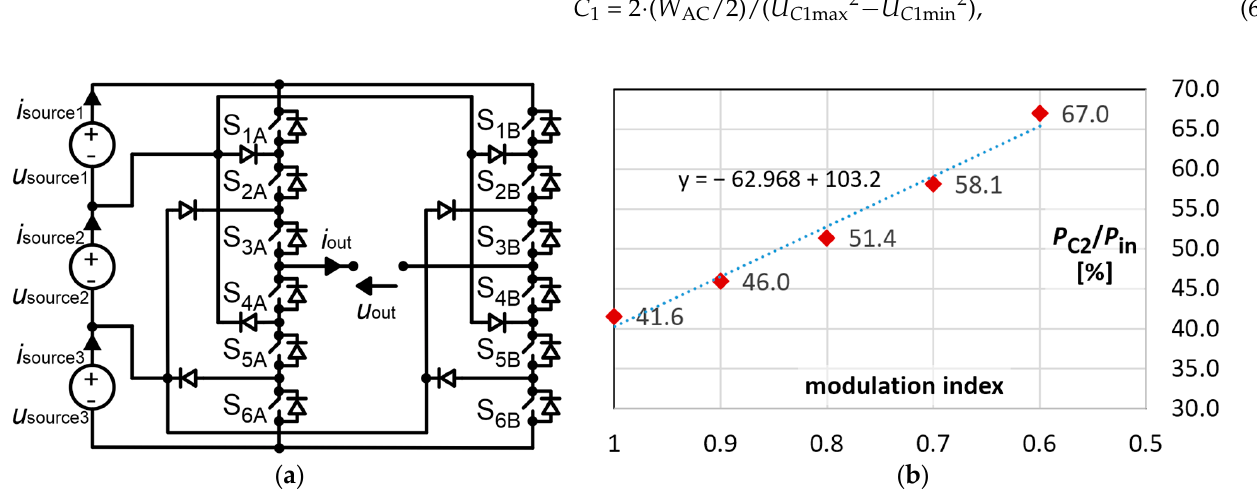
Figure 5. ( a ) the test circuit of the inverter with three input voltage sources, and ( b ) power of DC-link middle source (connected to C 2 DC-link capacitor) in the seven-level inverter (Figure 1) with the PD-PWM versus the modulation index.